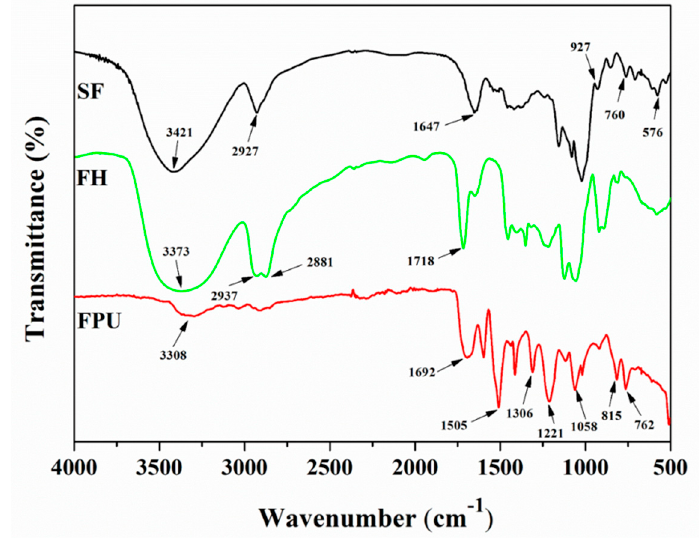
Figure 1. The FTIR spectra of SF, FH and FPU coating.